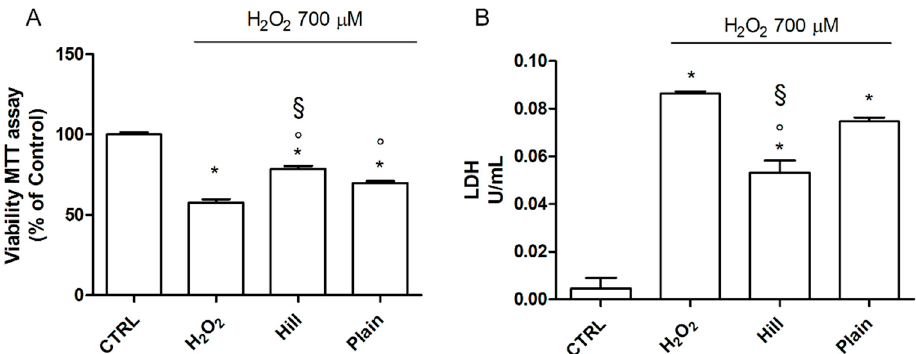
Figure 2. Neuroprotective activity of EVOO extracts against H 2 O 2 in SH-SY5Y cells. Cells were treated with 10 µ g/mL of the EVOO extracts for 24 h and then exposed to H 2 O 2 . ( A ) Cell viability was measured by MTT assay and ( B ) LDH was measured as LDH activity in in the culture medium as described in Materials and Methods. Each bar represents means ± SEM of at least three independent experiments. Data were analyzed by one-way ANOVA followed by Bonferroni’s test. * p < 0.05 with respect to CTRL; ° p < 0.05 with respect to H 2 O 2 ; § p < 0.05 with respect to plain.